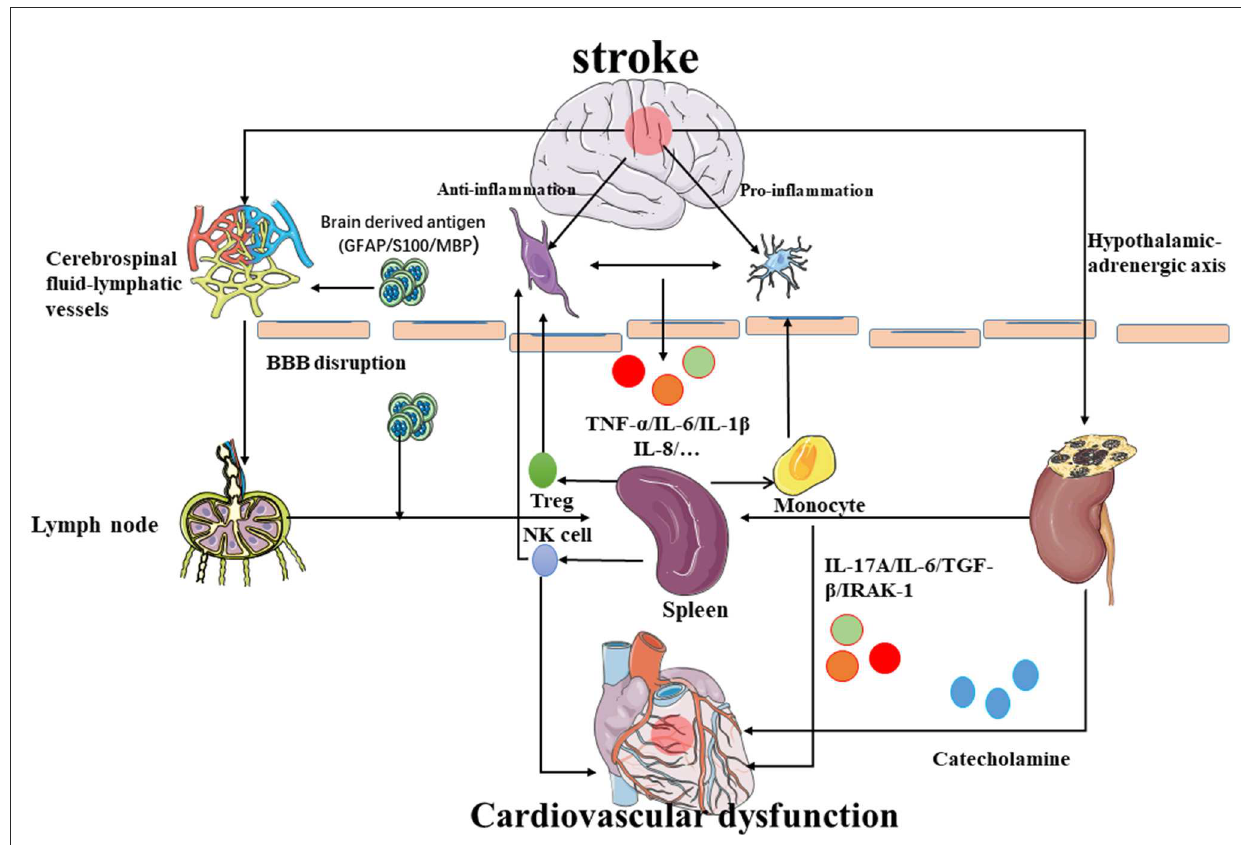
FIGURE3 Possible mechanism of brain–spleen–heart crosstalk: after stroke, the permeability of the blood–brain barrier increases, and the immune cells and inflammatory molecules in the brain reach the peripheral lymph nodes and spleen through the BBB to further regulate the occurrence of immune inflammation. The inflammatory molecules released by spleen activation mediate myocardial damage. Simultaneously, the spleen also releases NK cells and Treg cells into the brain to inhibit neuroinflammation while the monocytes would promote neuroinflammation. In addition, the inflammatory reaction near the hypothalamus can also promote the hypothalamic adrenaline axis to regulate the immune response of the spleen and heart damage.